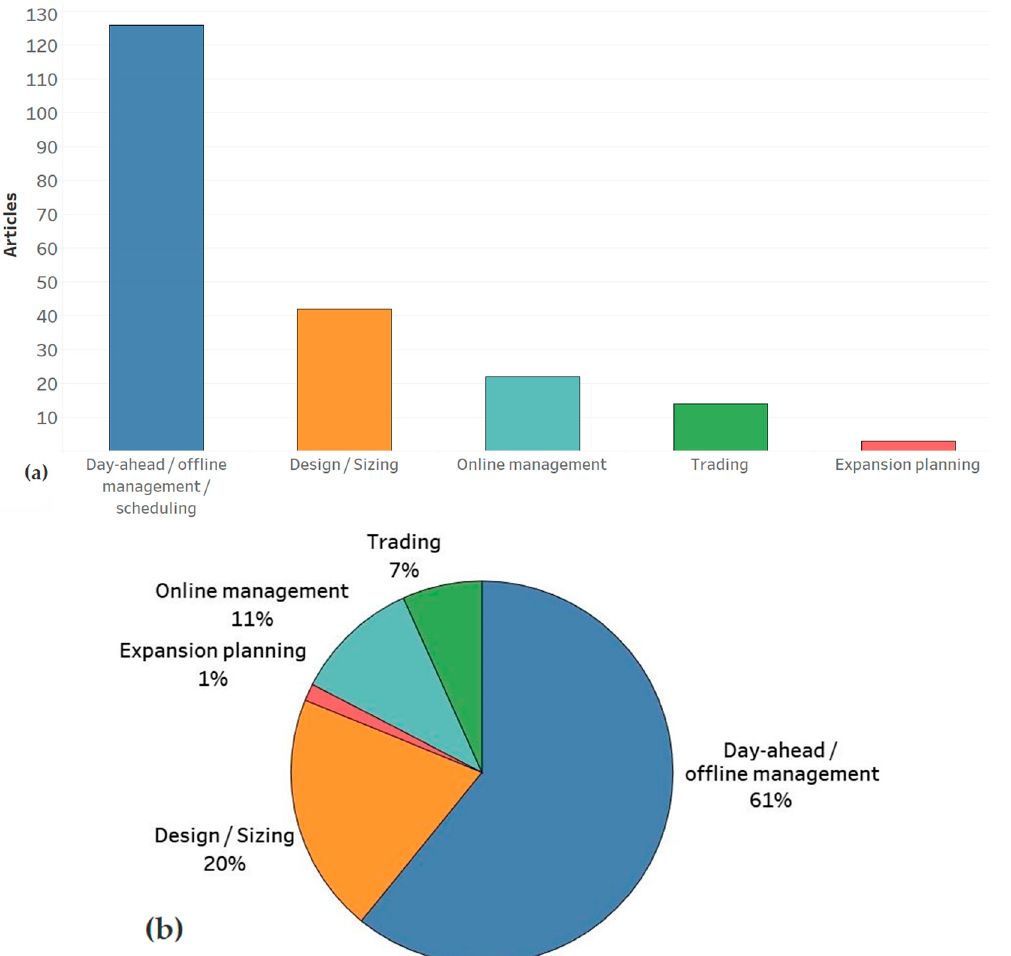
Figure 6. ( a ) Number of articles that deal with each problem type. ( b ) Share of each problem type in the total number of problems analyzed in the pool of articles. Note: each article may deal with more than one problem type. Self-elaboration.